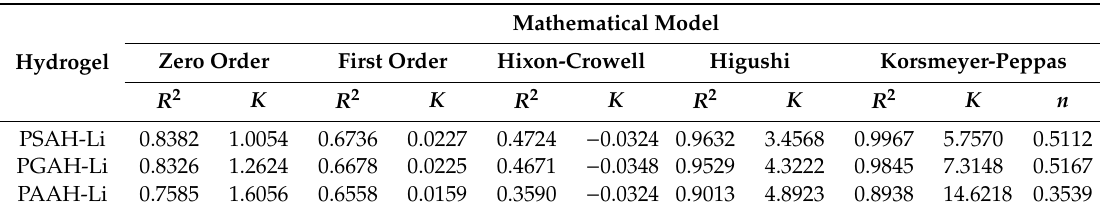
Table 6. Linezolid release kinetics and correlation coe ffi cient values from Fick, Hixon–Crowell, Higushi and Korsmeyer–Peppas